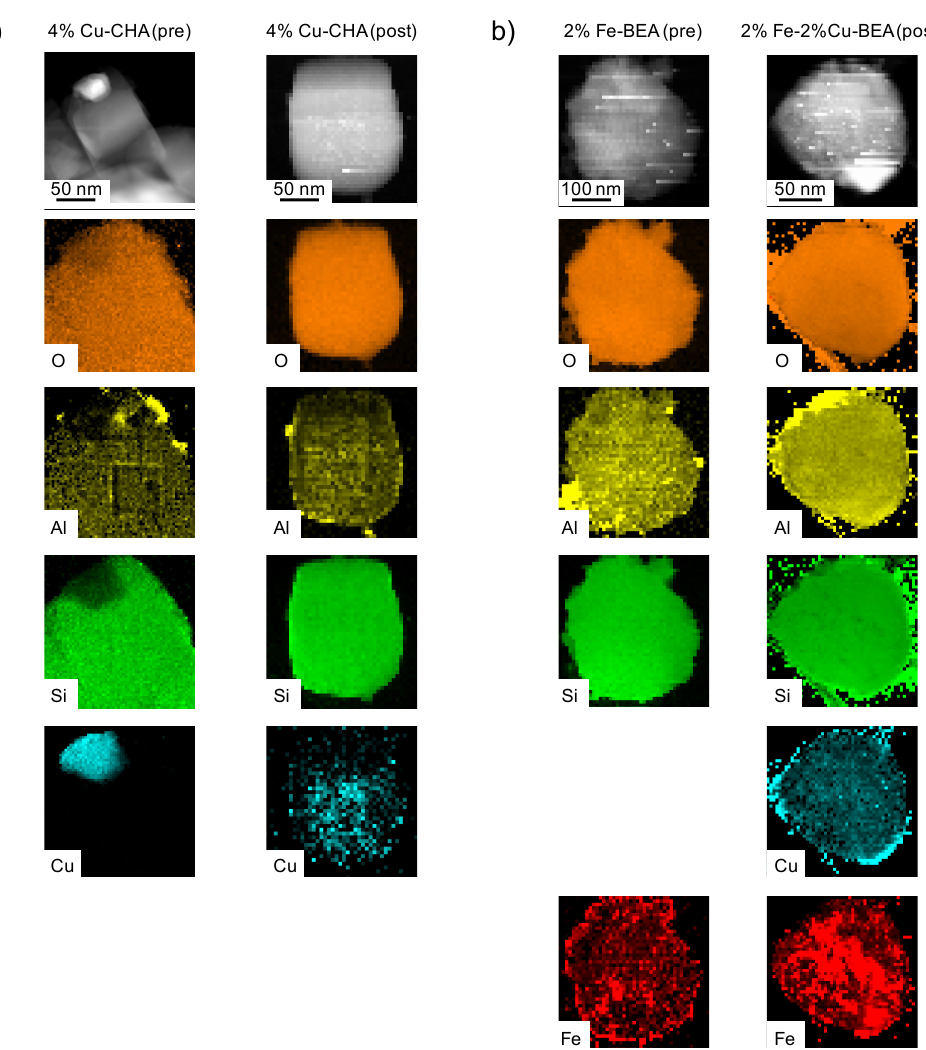
Figure 3. Scanning transmission electron microscopy (STEM) dark field images (top row) and energy-dispersive X-ray spectroscopy (EDS) maps of the distribution of oxygen (O), aluminium (Al), silicon (Si), copper (Cu) and iron (Fe) in single mixture ( a ) 4% Cu-CHA before (pre, left column) the [NH 3 +NO]-SSIE and after (post, right column) the [NH 3 +NO]-SSIE and ( b ) (2% Cu + 2% Fe)-BEA before (pre, left column) and after (post, right column) the [NH 3